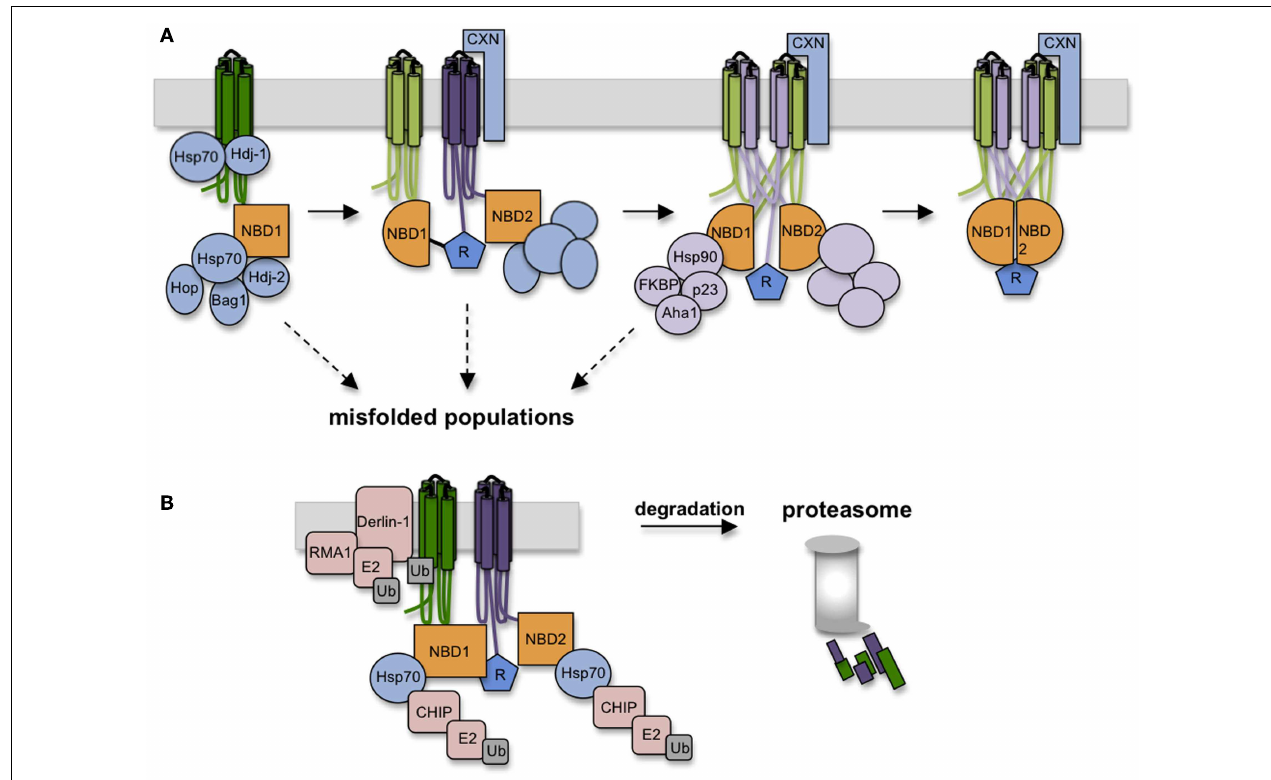
TMD2. Hsp70-Hop interactions recruits Hsp90 complexes which likely aid domain assembly in conjunction with calnexin. (B) Failure to achieve productive folding at any step in the folding pathway is detected by persistent binding of Hsp70, which serves to recruit E3 ligases (i.e., RMA1 and CHIP) that ubiquitinate CFTR and target it to the 26S